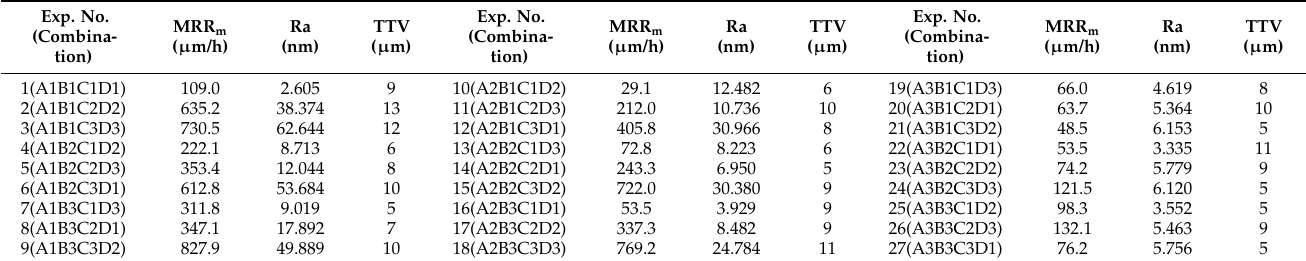
Table 3. Experimental results for MRR m , Ra, and TTV using the L 27 (3 13 ) orthogonal experiment.